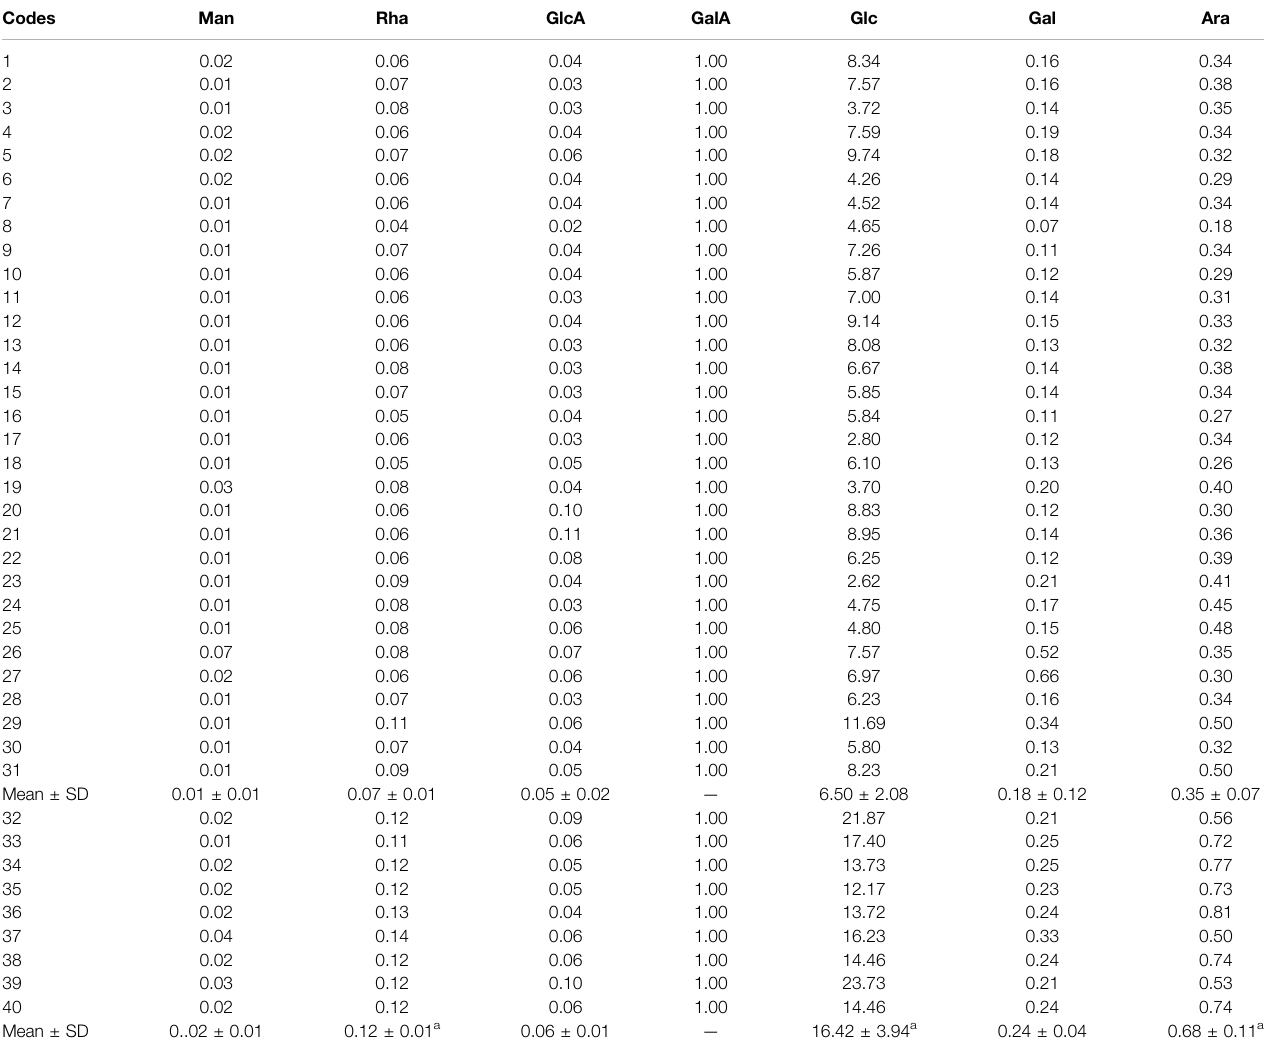
TABLE 2 | The monosaccharide composition of 40 polysaccharide samples. Codes Man